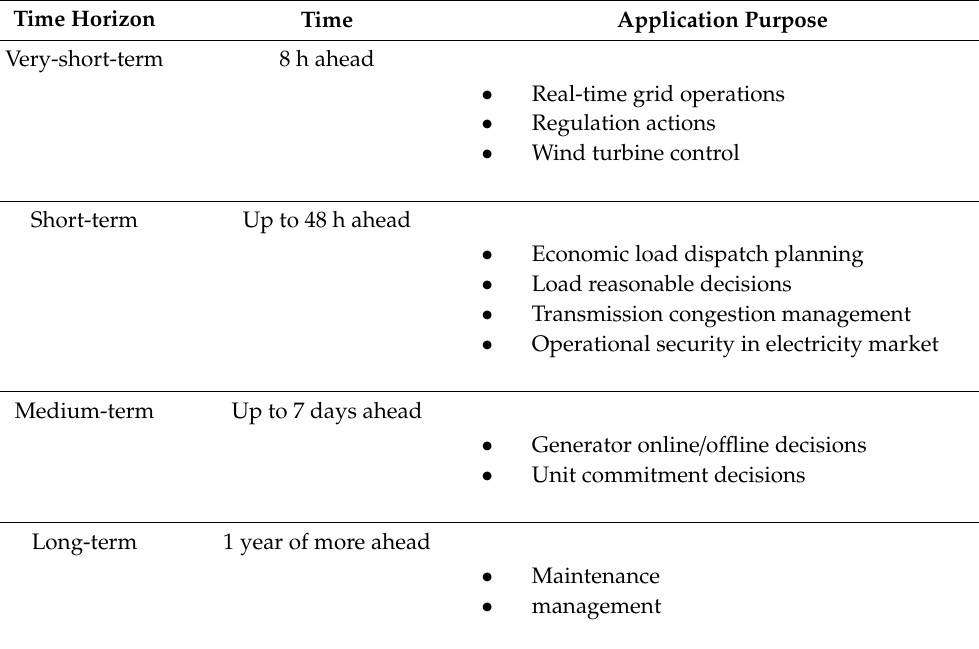
Table 2. Classification of time horizons for wind power